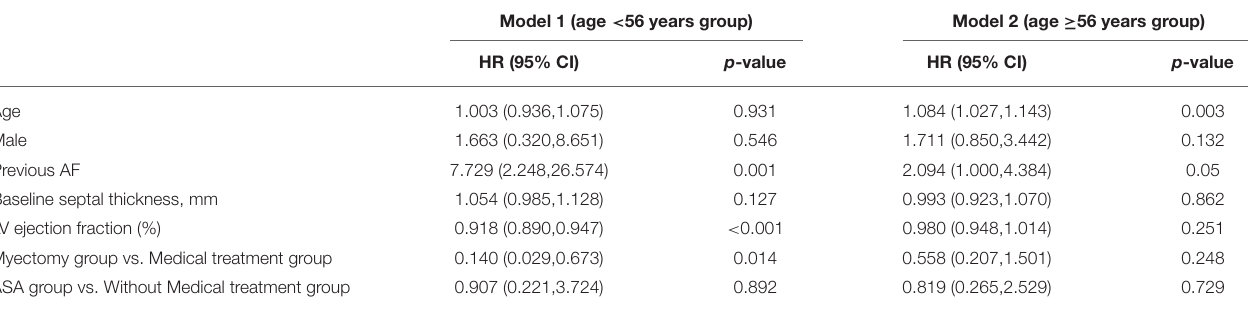
TABLE 5 | Multivariate Cox Analysis for All-Cause Mortality and Cardiac transplantation respectively in two groups (age < 56 year and age ≥ 56